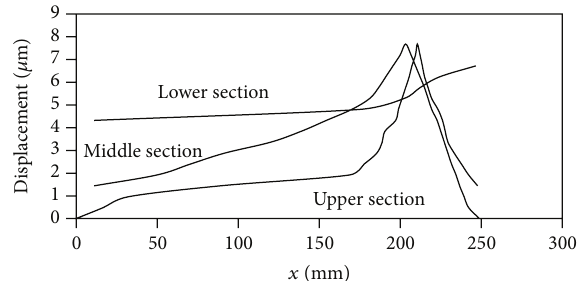
Figure 12: Displacement distribution in 𝑥 direction measured for the